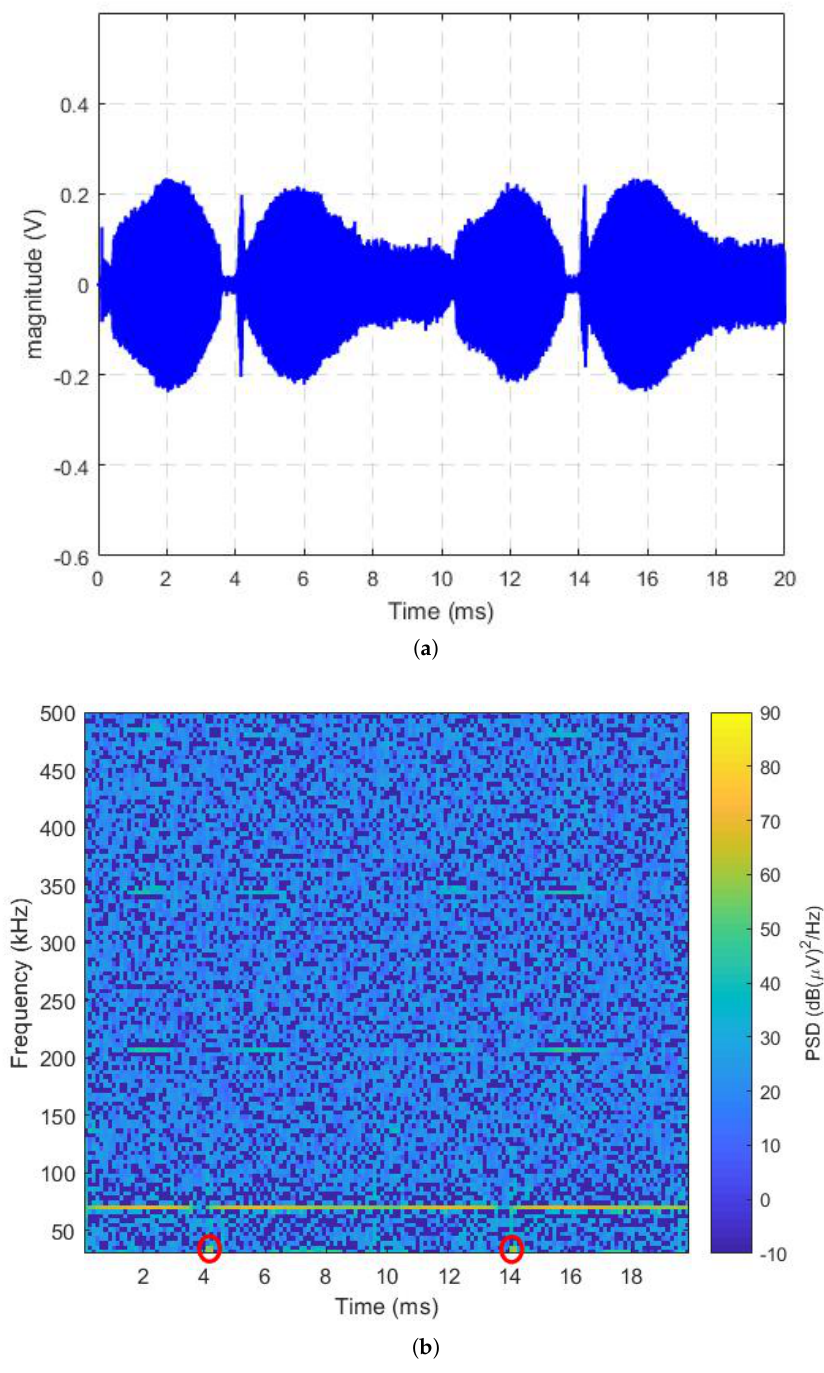
Figure 6. Noise measured in Italy ( a ) noise wave; ( b ) noise spectrogram